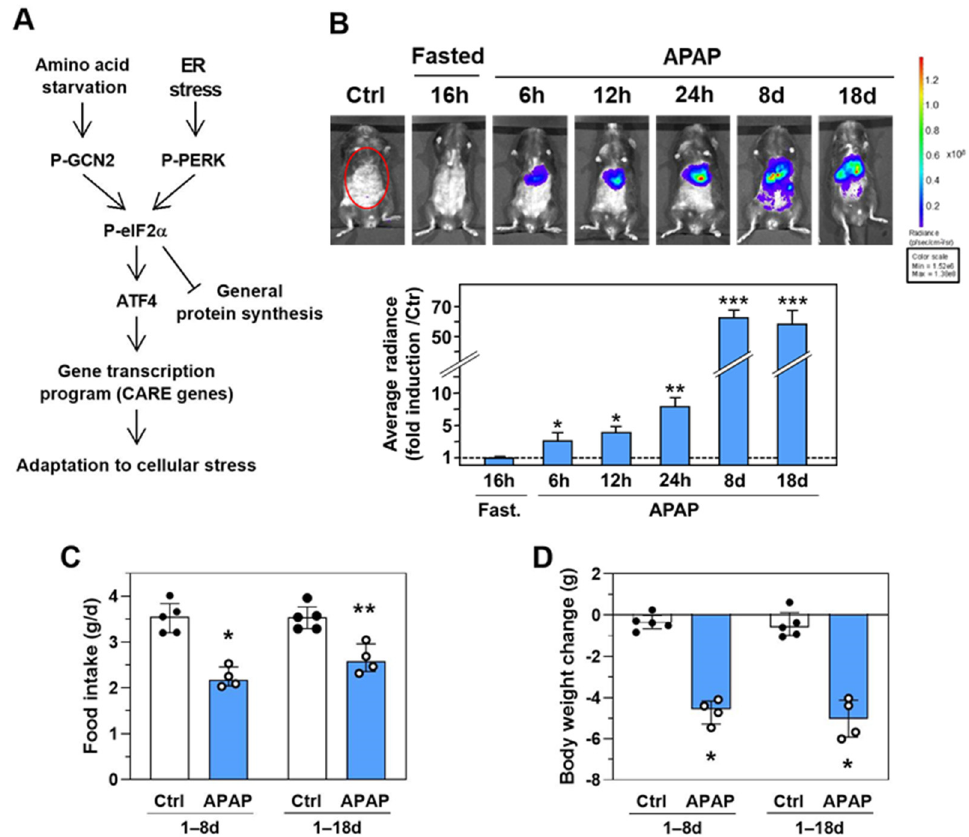
Figure 1. Visualization of the eIF2 α -ATF4 pathway activation in response to APAP treatment. ( A ) Scheme of the eIF2 α -ATF4 pathway. GCN2 is induced by essential amino acid starvation while PERK is activated by Endoplasmic Reticulum (ER) stress. These two kinases are active in their phosphorylated forms (P-GCN2 and P-PERK). The phosphorylation of eIF2 α upregulates the translation of ATF4 mRNA. The transcription factor ATF4 enhances the transcription of many CARE-dependent genes that play a critical role in the adaptation to cellular stress. ( B ) CARE-LUC mice were fasted for 16 h and then fed a diet with 1% APAP (APAP) for 18 d ad libitum . Ventral views of representative mice are depicted at 6, 12, 24 h, 8, and 18 d. Photon emission was quantified using ROIs covering the abdominal area (red circles) as described in Materials and Methods. Results are given as the fold induction relative to the control (Ctrl) value. The graphs show means ± S.E.M. of 6 mice. * p ≤ 0.05; ** p ≤ 0.01; *** p ≤ 0.001 compared to the respective Ctrl value, Student’s t -tests. ( C ) Mean daily food intake for 1–8 d and 1–18 d of CARE-LUC mice receiving the Ctrl diet (Ctrl) or the APAP diet (APAP) ad libitum. ( D ) Body weight change during the experiment. In C and D graphs, each bar shows the median with interquartile, and dots are individual values. * p ≤ 0.05; ** p ≤ 0.01 vs. respective Ctrl; Mann Whitney test.